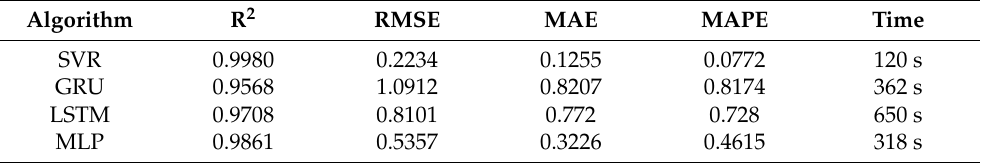
Table 5. Evaluation and comparison of SVR and deep learning prediction models.